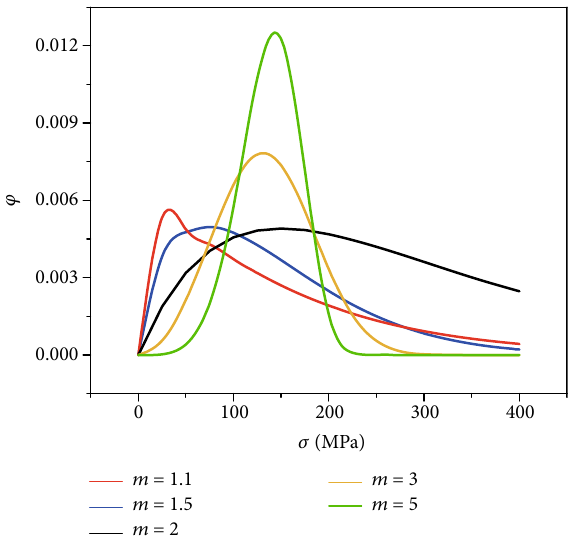
Figure 2: Strength distribution for fi ve di ff erent heterogeneous coe ffi cients.